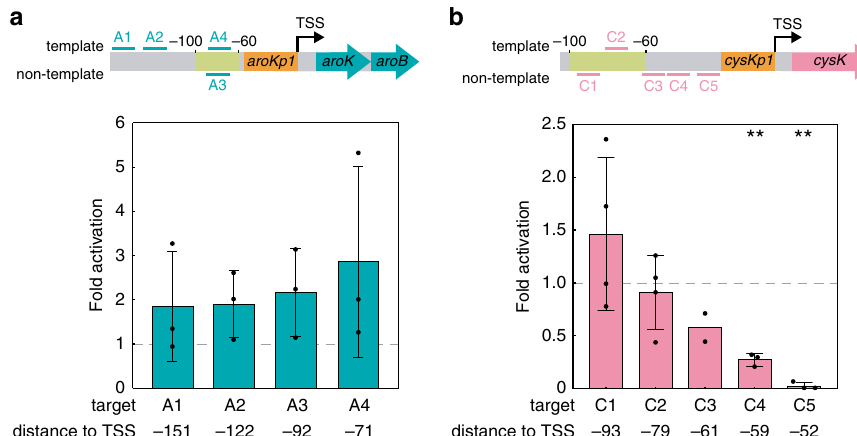
Fig. 2 A simple distance metric does not predict CRISPRa activity. a CRISPRa on the aroK-aroB operon. Two scRNA target sites within the 40 base window where CRISPRa is effective ( − 100 to − 60) in heterologous reporter genes (A3 – A4) and two sites further upstream (A1 – A2) were chosen for the aroKp1 promoter. b CRISPRa on the cysK gene. Three scRNA target sites within the 40 base window where CRISPRa is effective in heterologous reporter genes (C1 – C3) and two sites further downstream (C4 – C5) were chosen for the cysKp2 promoter. The C4 and C5 sites resulted in repression; targeting these sites close to the core promoter may interfere with RNA polymerase binding. Gene expression was measured using RT-qPCR. Fold activation represents expression levels relative to a strain expressing an off-target scRNA (hAAVS1). In a and b , bars represent the average ± standard deviation calculated from n = 4 (C1, C2), n = 3 (A1 – 4, C4,C5), or n = 2 (C3) biologically independent samples. Some individual replicates in samples A1 – 4 and C1 – 2 appear to show activation, but a two-tailed unpaired Welch ’ s t test indicates that the average differences relative to the off-target control are not statistically signi fi cant ( p value > 0.05). Targeting CRISPRa to C4 – 5 resulted in repression, likely owing the short distance between the sites and the promoter. Stars indicate a statistically signi fi cant difference from the off-target control using a two-tailed unpaired Welch ’ s t test (** p value < 0.01). Exact